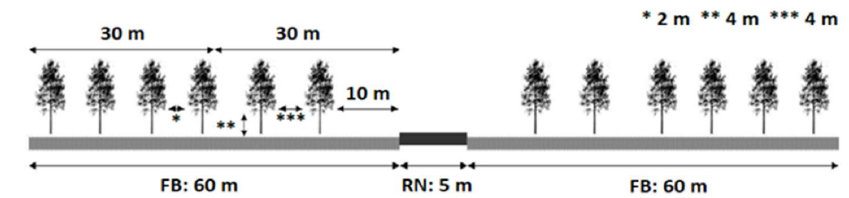
Figure 1. Technical specifications of a fire break (FB) in the Portuguese fire break network (FBN) [6].